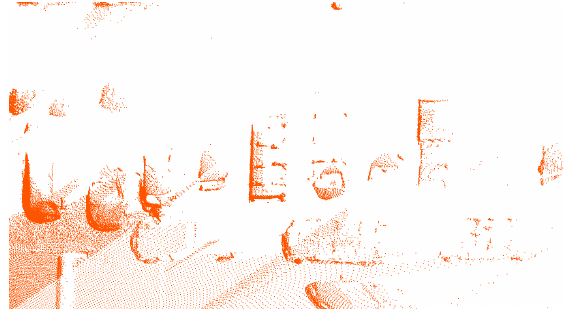
Figure 1. The scanned point clouds of a parking